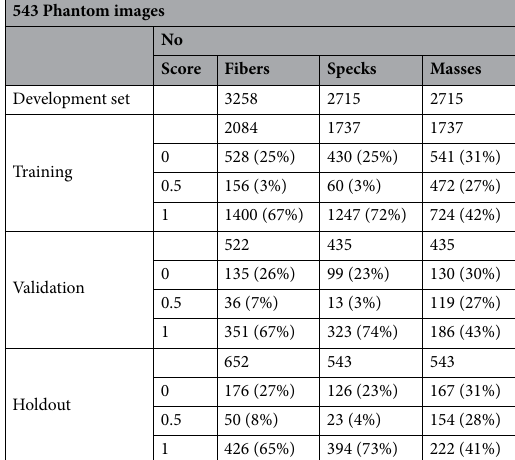
Table 2. Development data set status and